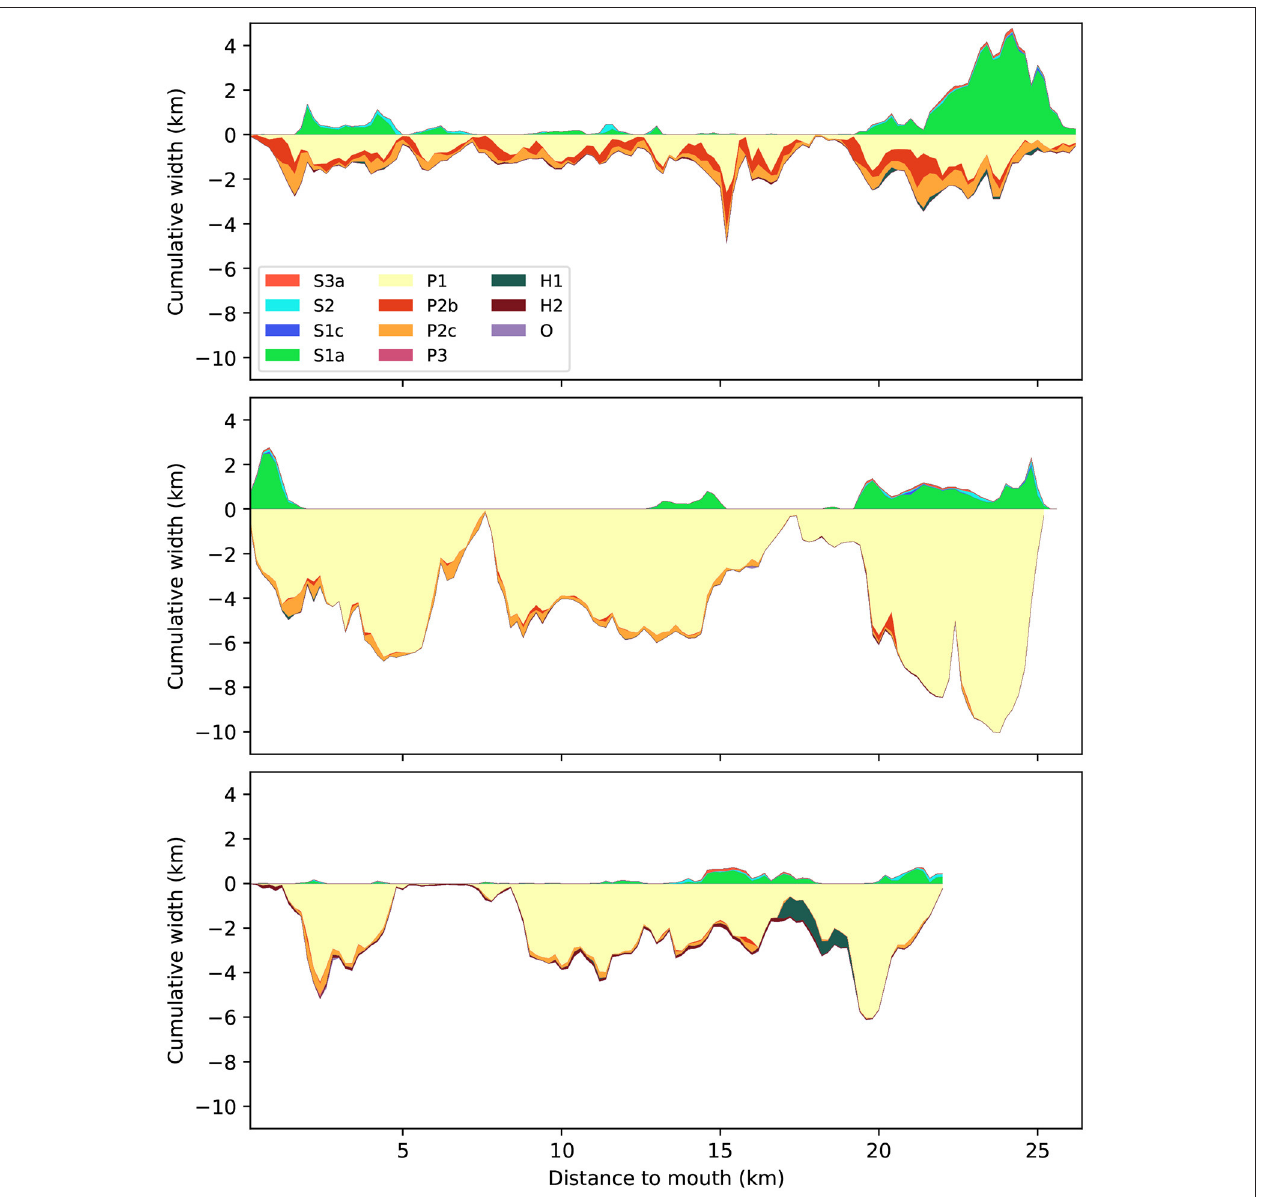
FIGURE 5 | Distribution of biogeomorphological classes divided by vegetated and unvegetated parts, plotted as absolute width along the Western Scheldt (top) , Eems-Dollard (middle) , and Eastern Scheldt (bottom) . Positive widths refer to subtidal bed surface and to all vegetated classes, negative widths refer to unvegetated intertidal flat classes and the sum of absolute widths is the cumulative estuary width excluding water. Distance is measured along a centerline from the narrowest cross-section in the seaward mouth. For explanation of legend see Table 2 .